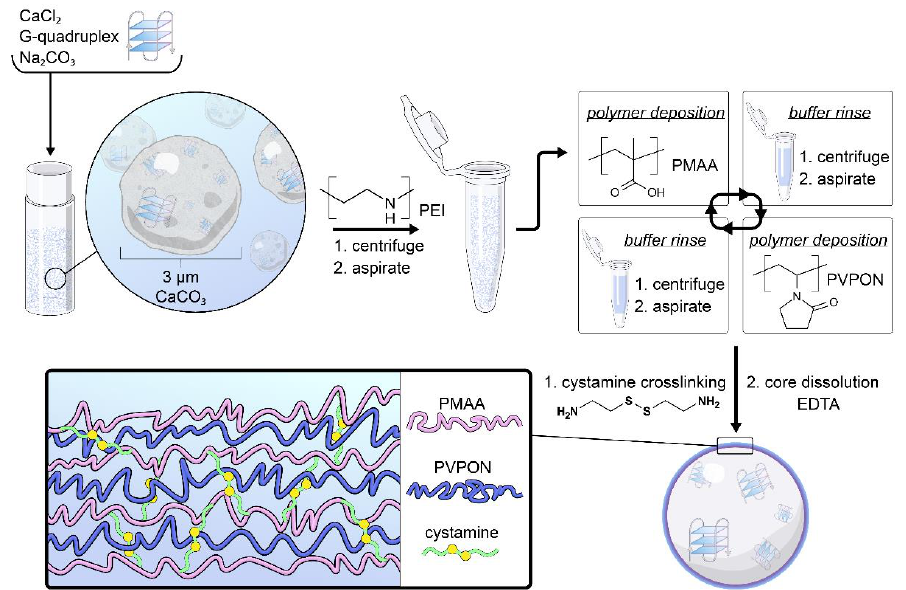
Figure 1. Fabrication of the (PMAA/PVPON) n multilayers. The DNA-loaded (PMAA/PVPON) n microcapsules were prepared by co-precipitation of Na 2 CO 3 and CaCl 2 salts with G-quadruplex or dsDNA in aqueous solution. PEI was adsorbed onto particle surfaces to increase interaction with the first PMAA layer. PMAA and PVPON were alternatingly adsorbed onto particles surfaces until the desired number of bilayers (n) was formed. The core-shells were crosslinked with cystamine